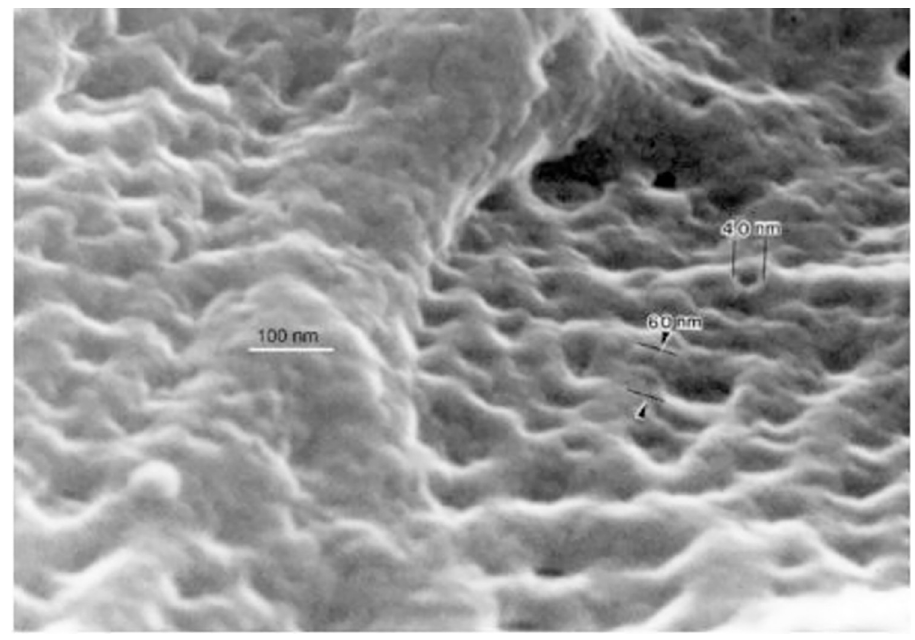
Fig 2. High-resolution SEM of the luminal surface of a capillary coated with Au:Pd [13]. Here the molecular detail on the luminal surface appears obscured, due to bulky coating, thus resulting in loss of ultrastructural detail.